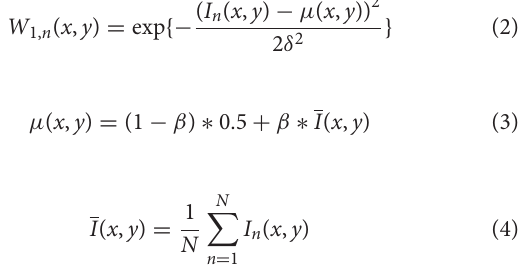
pixel weight of the n th image. The workflow of the proposed image fusion based on improved weight function is shown in Figure 1 . Equation (7), Equation (8) and other symbols in Figure 1 correspond to the formula below, indicating that the operation corresponding to the equation has been